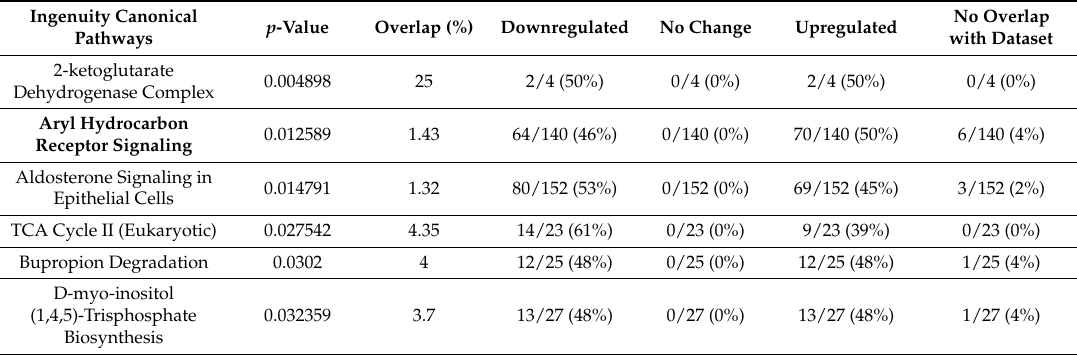
Table 3. Canonical pathways activated by 20,23(OH) 2 D3 in human epidermal keratinocytes after 6 h of treatment. Nuclear receptors are marked in